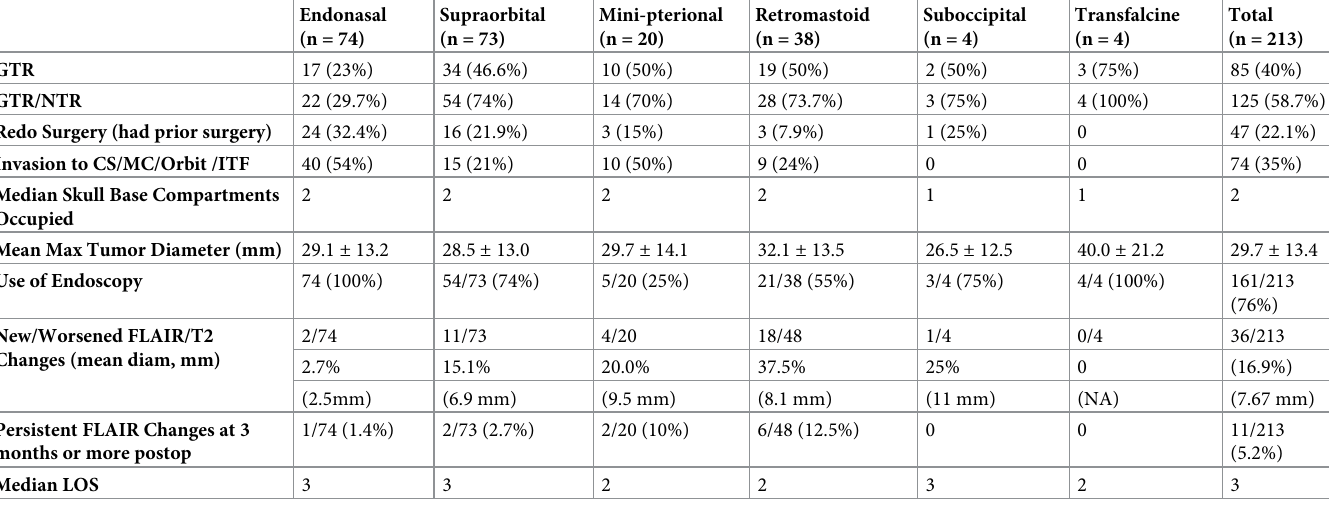
Table 2. Meningioma characteristics, resection rates & surgical parameters for 213 keyhole operations.